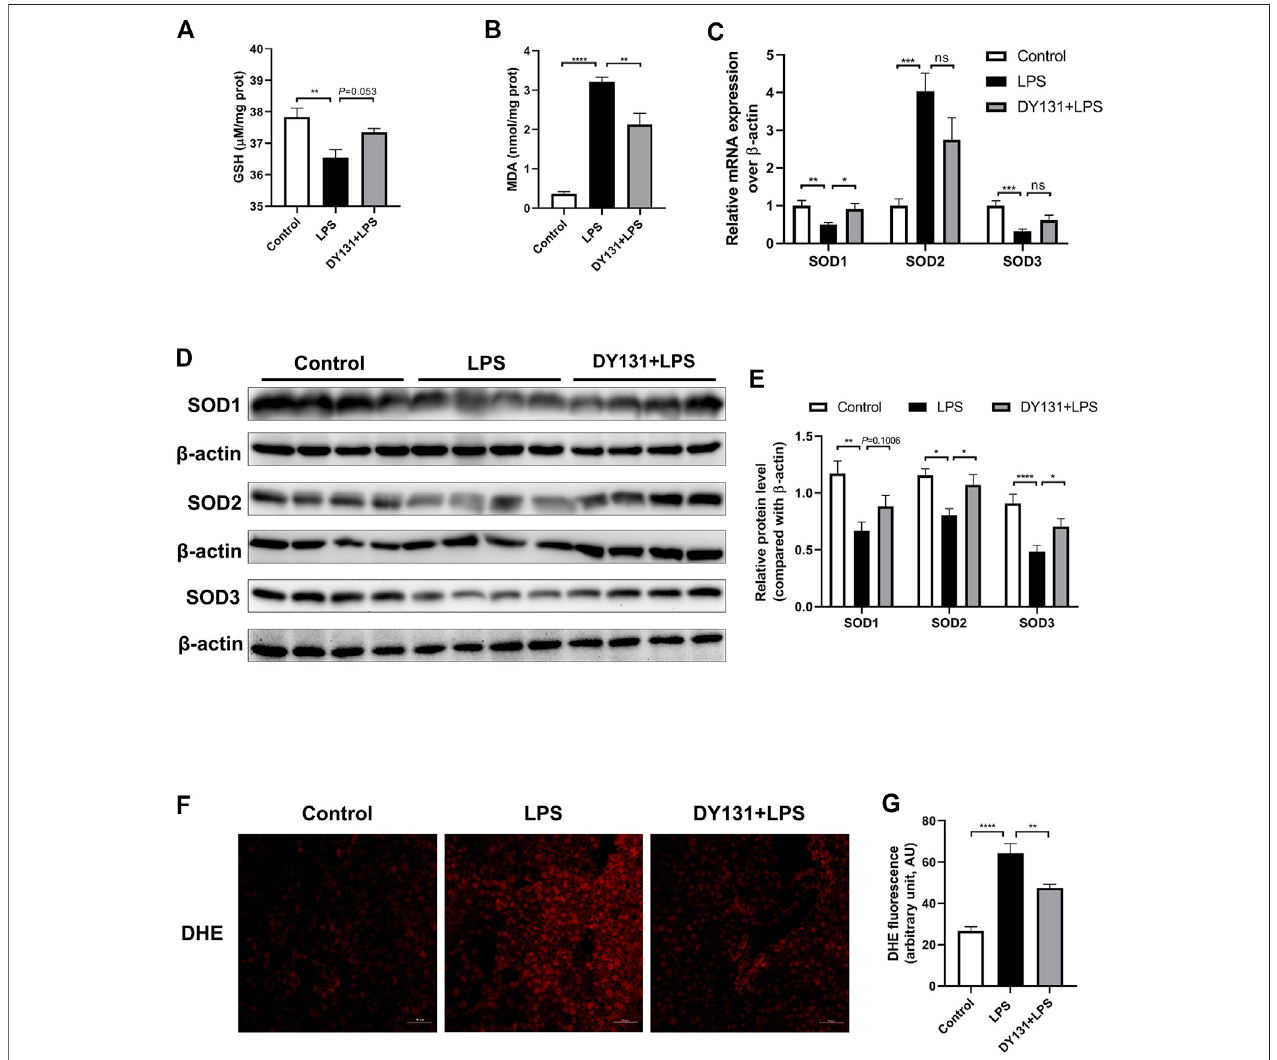
FIGURE 3 | DY131 ameliorated oxidative stress in LPS-treated mice. (A,B) The levels of the antioxidant GSH and oxidative stress marker MDA in livers were measured using a commercial kit (n (cid:1) 10 in each group). (C) mRNA expressions of SOD1, SOD2, and SOD3 were determined by qRT-PCR (n (cid:1) 10 in each group). (D) ProteinlevelsofSOD1,SOD2,andSOD3weredetectedbyWesternblotting(n (cid:1) 8ineachgroup). (E) QuantitativeanalysesofSOD1,SOD2,andSOD3bydensitometry (n (cid:1) 8 in each group). (F) Representative images of DHE staining of liver tissues in different groups (magni fi cation × 200, scale bar: 50 μ m, n (cid:1) 3 in each group). (G) Quanti fi cation of the mean fl uorescence intensity of DHE was analyzed by ImageJ software. Data were presented as means ± SEM. * p < 0.05, ** p < 0.01, *** p < 0.001 and **** p < 0.0001 vs. the indicated group. NS, no signi fi cance.